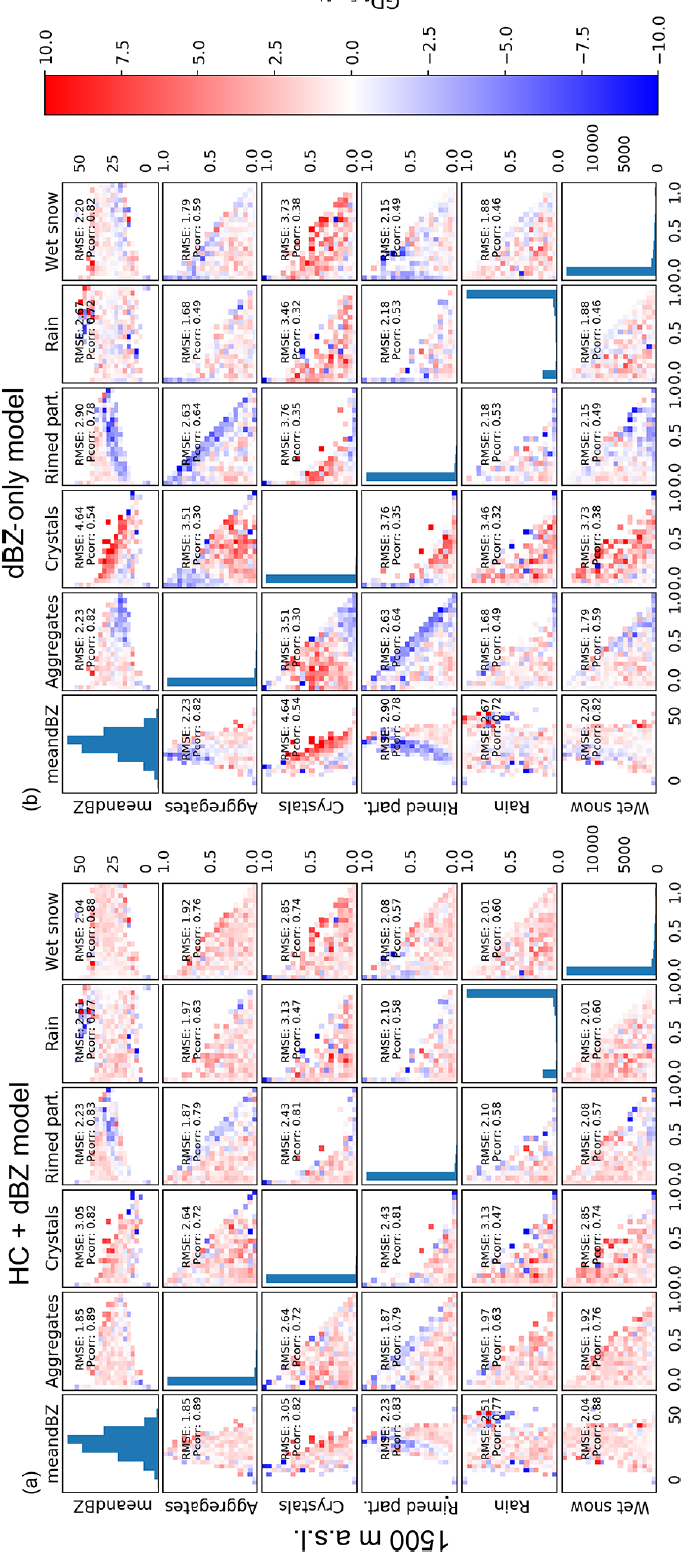
Figure 8. The 2-D error matrices from 1500ma.s.l. for the HC + dBZ model (a) and dBZ-only model (b) . The colour for each bin is based on the difference between the observed binned average and the binned average of the model